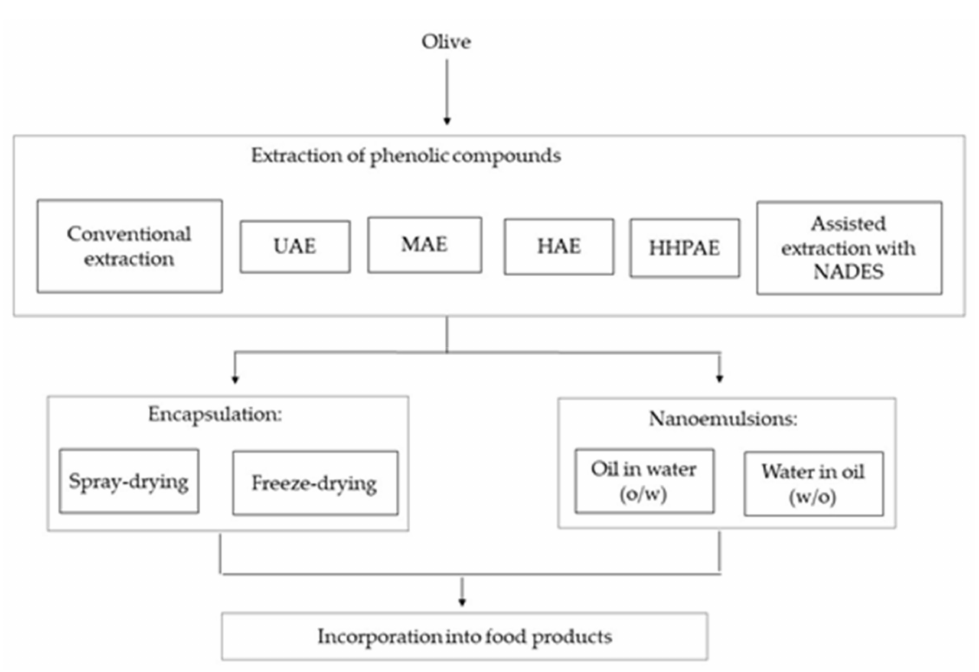
Figure 2. Flow chart for the integrated valorization approach of olive pomace based on the ex- traction of phenolic compounds and their protection by encapsulation. NADES: Natural Deep Eutectic